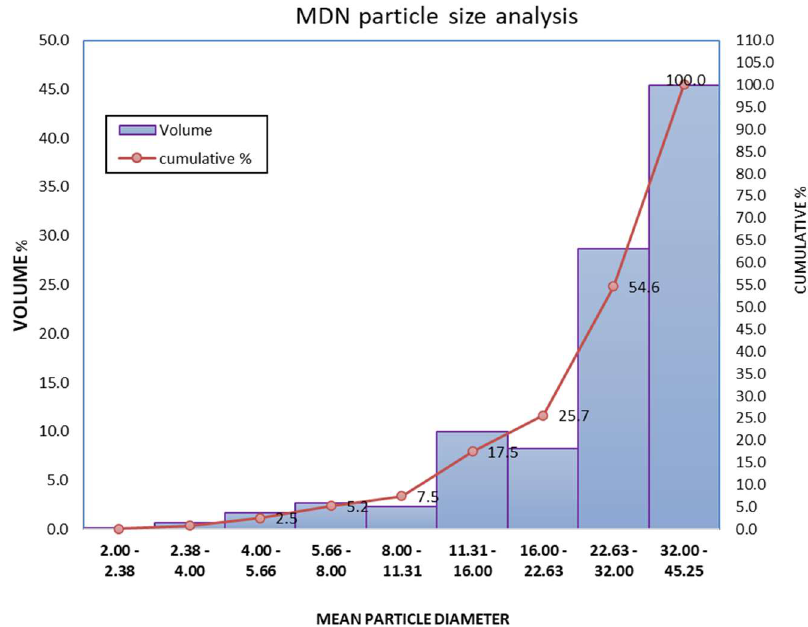
Fig. 5. MDN particle size analysis, showing two series of data: the blue one represents the volume diameter of MDN particles, and the orange series represents the cumulative percentages. More than fifty percent of the particles had volume diameter equal or less than 28.7